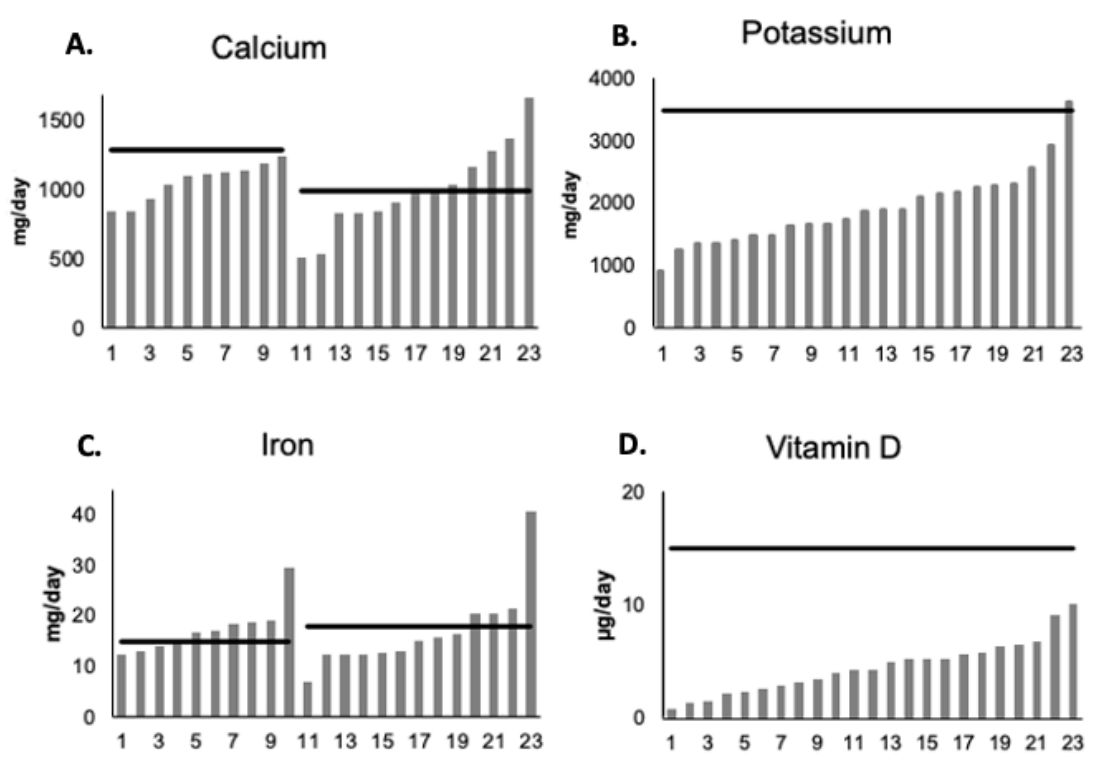
Figure 2. Average daily intake of ( A ). calcium (RDA = 1000–1300 mg), ( B ). potassium (recommended dietary allowance (RDA = 3500 mg), ( C ). iron (RDA = 15–18 mg), and ( D ). vitamin D (RDA = 15 µ g). n = 23. Participant data listed from lowest to highest intake.